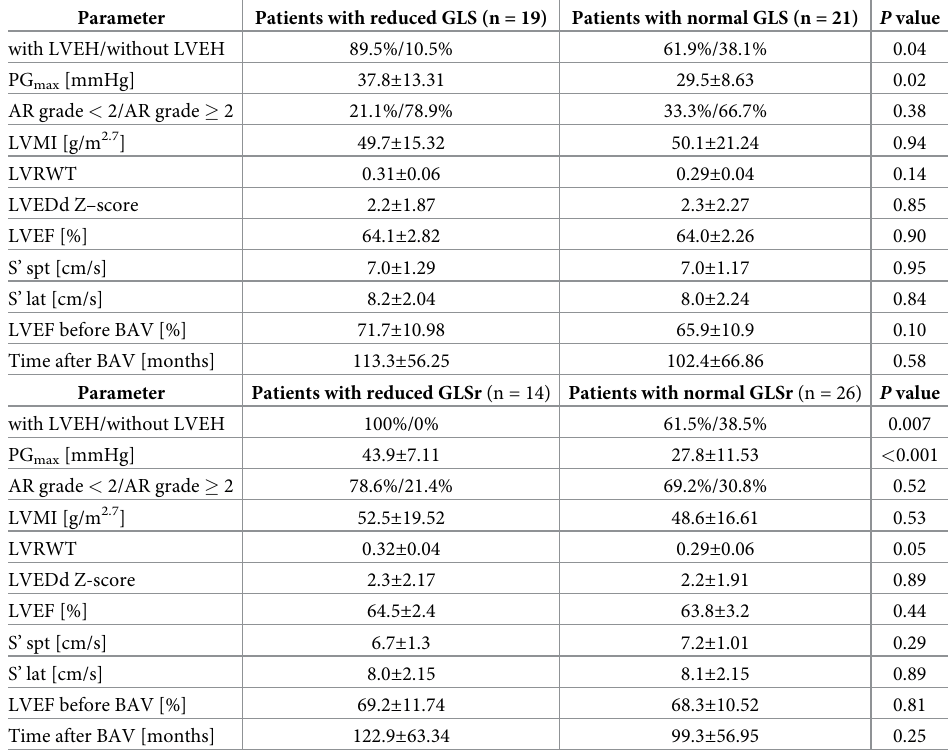
Table 4. Risk factors for left ventricular systolic dysfunction defined as GLS > - 19.31% and GLSr > - 0.8/s in the study group.